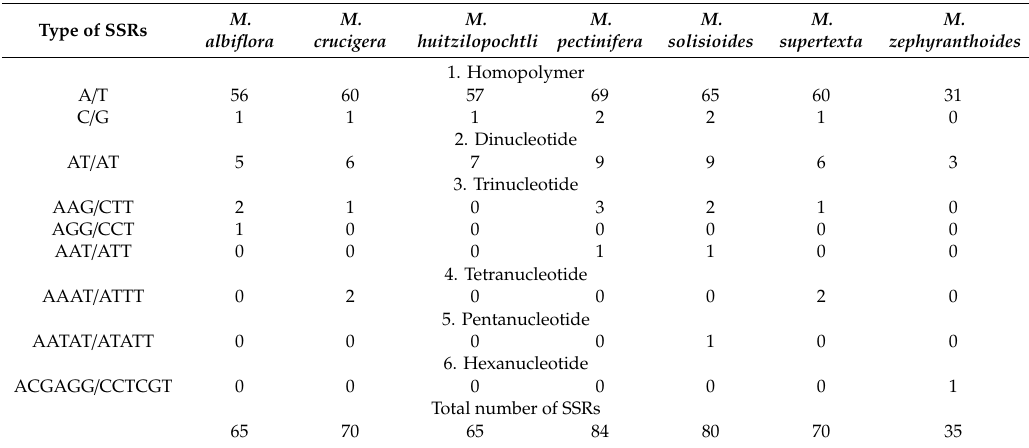
Table 1. Type and number of Short Sequence Repeats (SSRs) in the complete chloroplast genomes of the seven analyzed species.